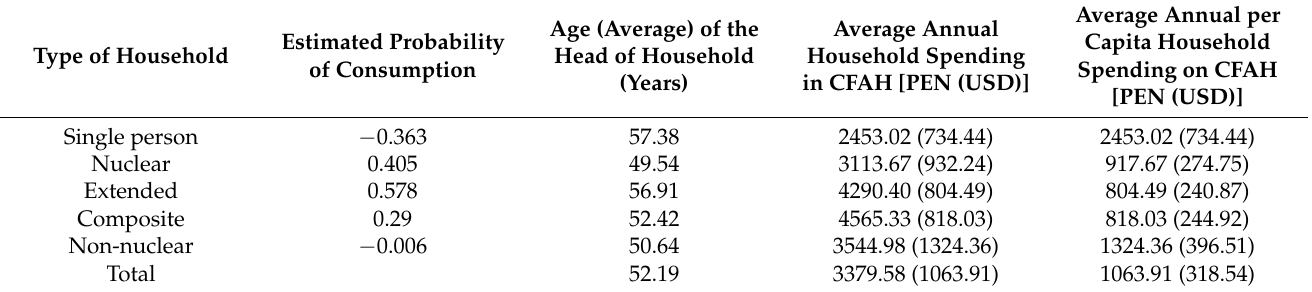
Table 2. Types of households and the probability of food consumption outside the home and, household expenditure and per capita expenditure, ENAHO